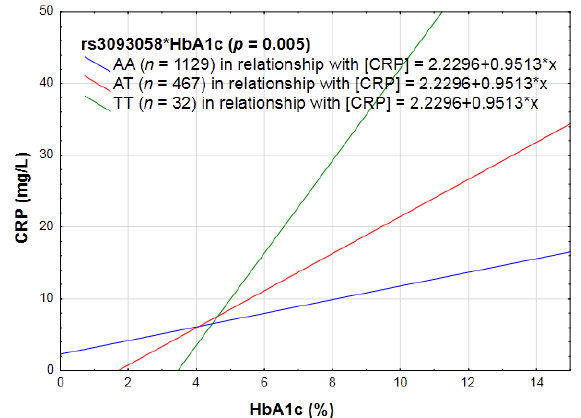
Figure 3. The linear relationship between HbA1c in relation to CRP concentrations categorized for rs3093058.